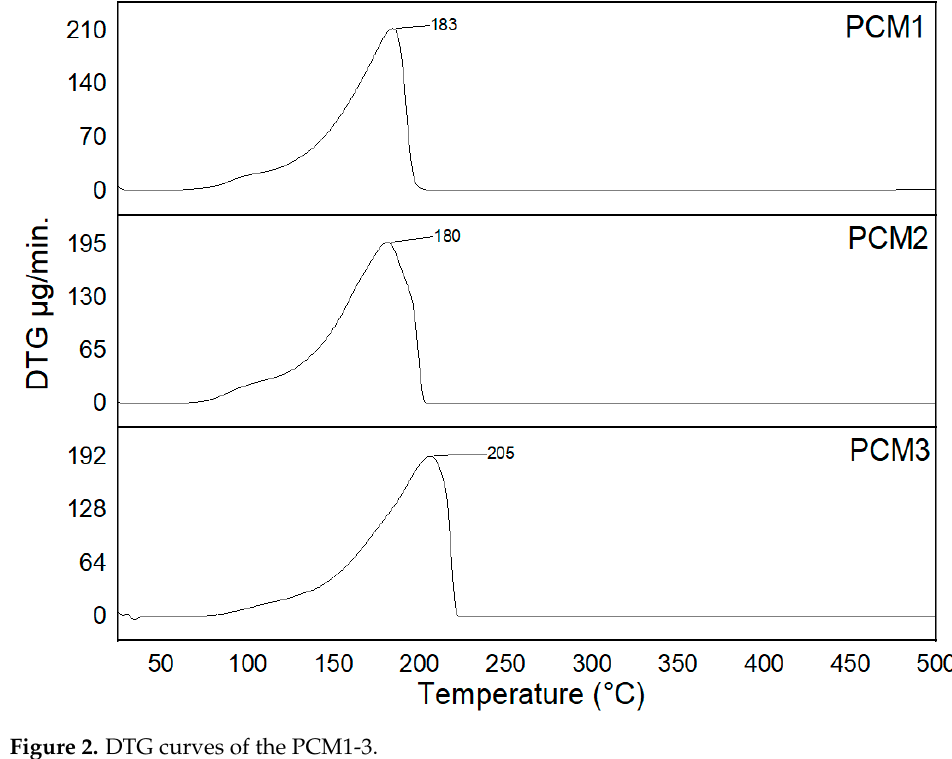
Figure 1. TGA curves of the PCM1-3.